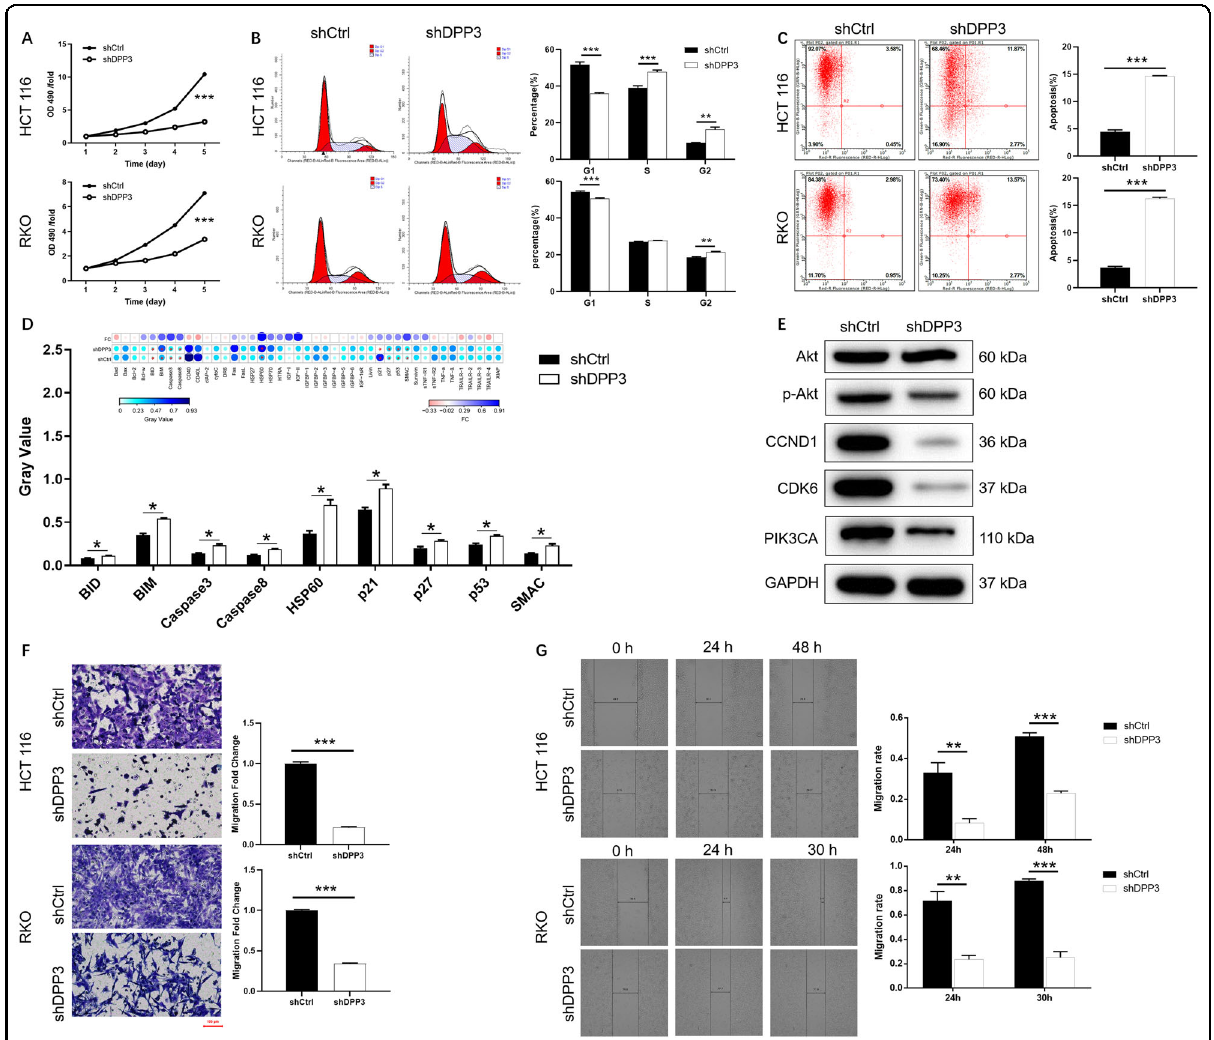
knockdown. D Human apoptosis antibody array was utilized to analyze the regulatory ability of DPP3 on expression of apoptosis-related proteins in HCT 116 cells. E The protein expression of downstream molecular in HCT 116 cells with or without DPP3 knockdown was measured by WB. F , G CRC cell migration ability was accessed by Transwell assay ( F ) and wound-healing assay ( G ). The representative images were selected from at least three independent experiments. Data were shown as mean ± SD. * P < 0.05, ** P < 0.01, *** P <